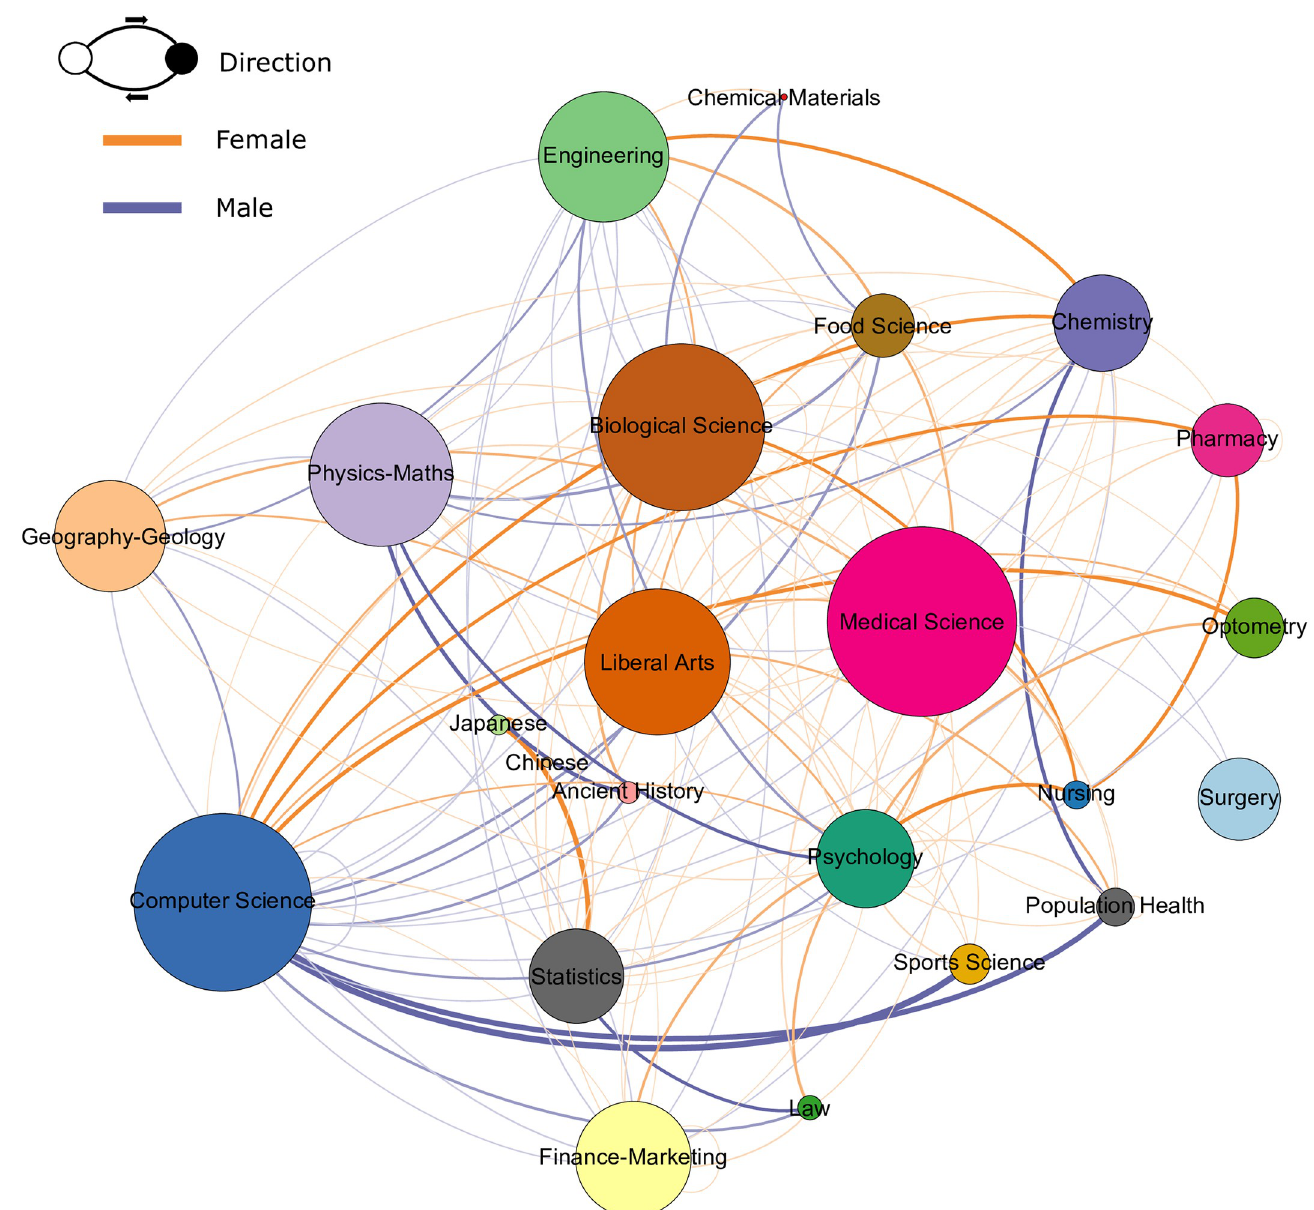
Fig 3. Course community network. The above directed network represents the network seen in Fig 2, only the links within communities (i.e. links between courses belonging to the same community) and between communities have been split by gender and aggregated. Odds ratios comparing the likelihood of a female student taking a course in community m and community n were formulated, with the resulting values used as edge weights. The communities were labelled based on the range of courses that it is comprised of. Edges where female students were more likely to take a course in community m and community n are coloured orange, while edges where male students were more likely to take a course in community m and community n are coloured purple. When considering the flow between a pair of nodes connected by two edges, the direction of flow is outward following the link in a clockwise direction. The network shows that transverse movements from fields such as computer science and physics-maths to other domains tend to be female dominated, whilst movements into these fields are more male